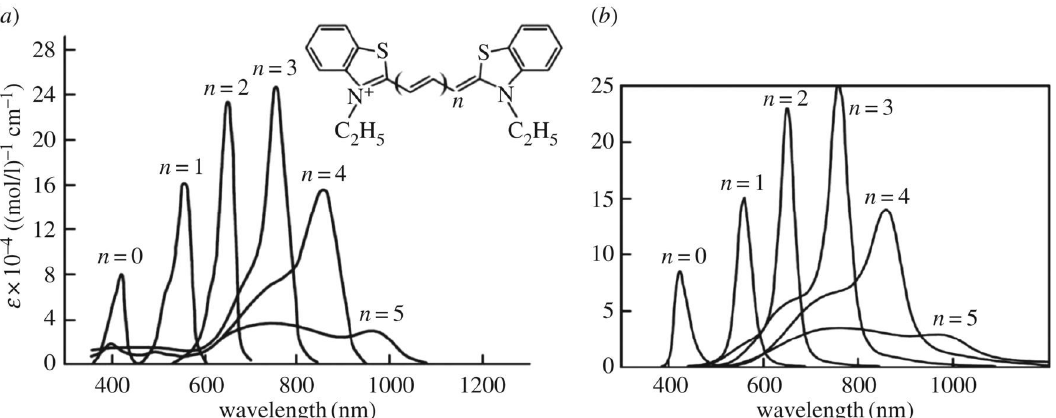
Figure 2. Shapes of optical absorption bands and Egorov nano-resonance ( n = 3) in a series of polymethine dyes with varying lengths of polymethine chain L = 2 ( n + 2) d , where d are certain roughly equal bond lengths (0.14 nm) in the chain (thiapolymethinecyanine in methanol at room temperature; ε is the extinction coefficient) [7,8]. ( a ) Experimental data [35,36] and ( b ) theoretical modeling [24,37] based on quantum–classical mechanics [5]. (Original citation)—Reproduced by permission of The Royal Society of Chemistry.